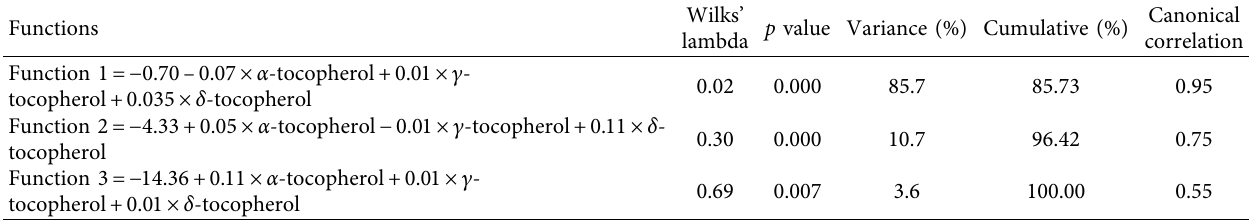
Table 3: Discriminant functions elaborated based on the tocopherols composition.